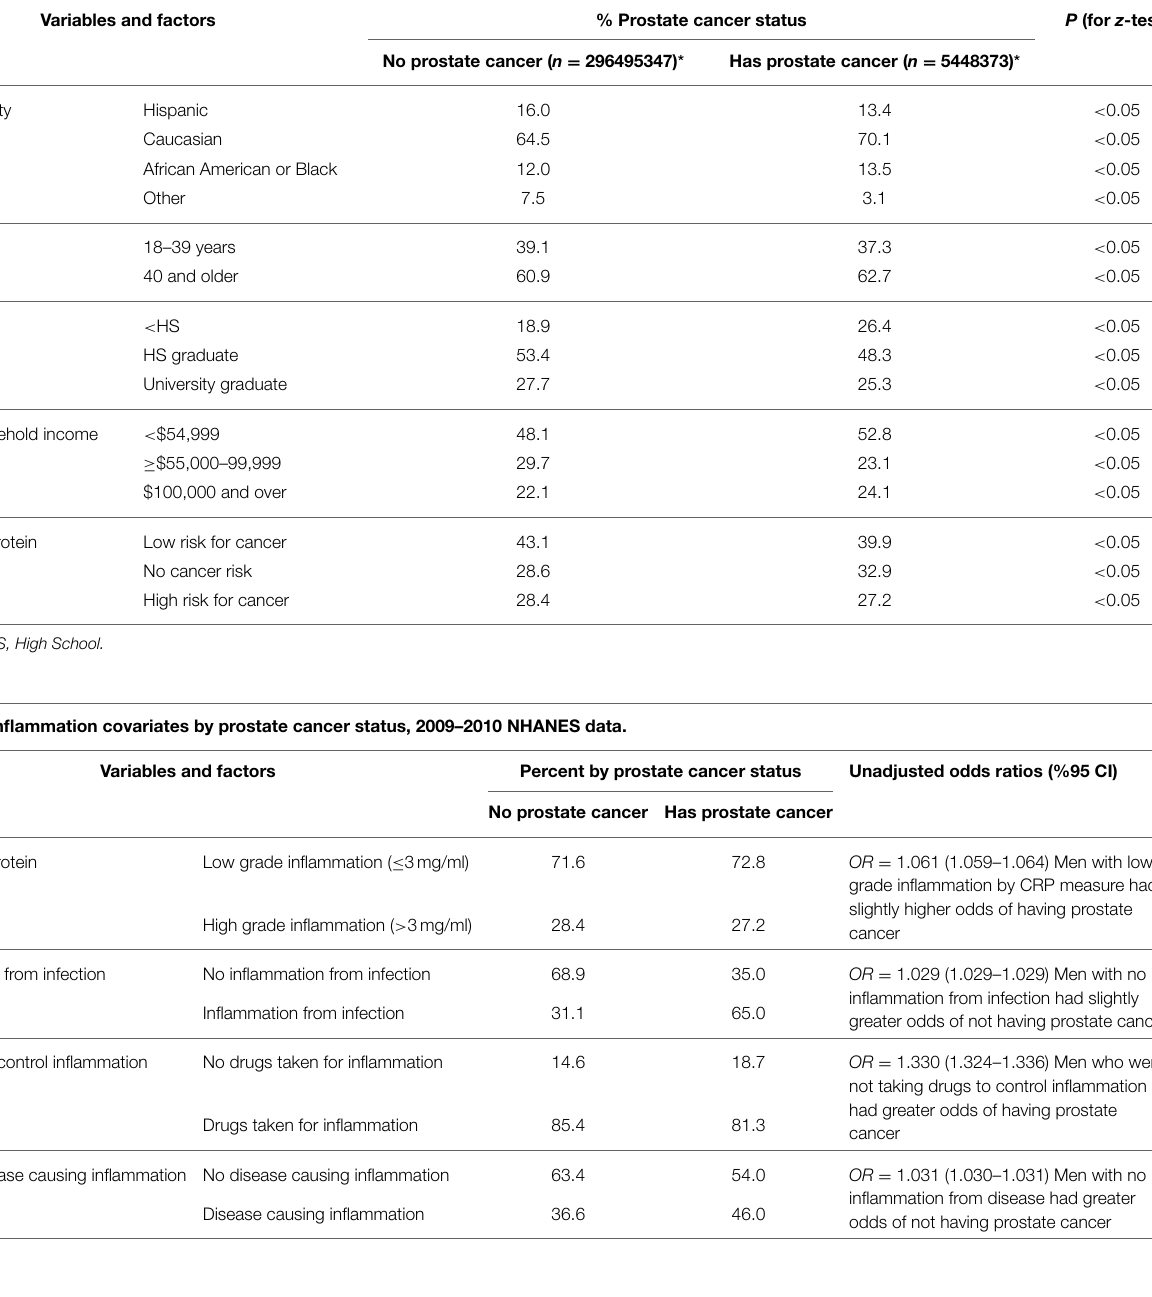
TABLE 1 | Description of study population by prostate cancer status, 2009–2010 NHANES data.